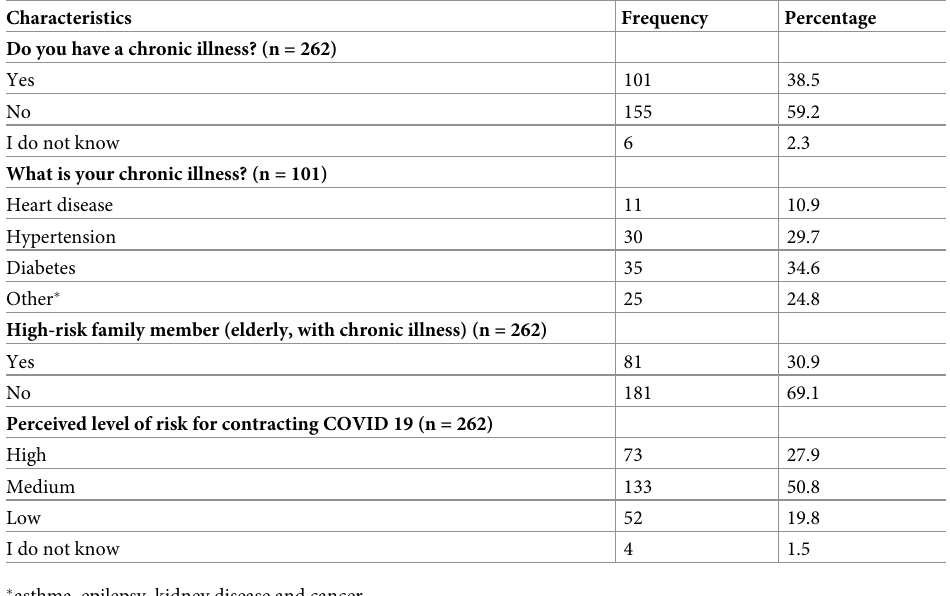
Table 2. Perceived risk of COVID-19 among